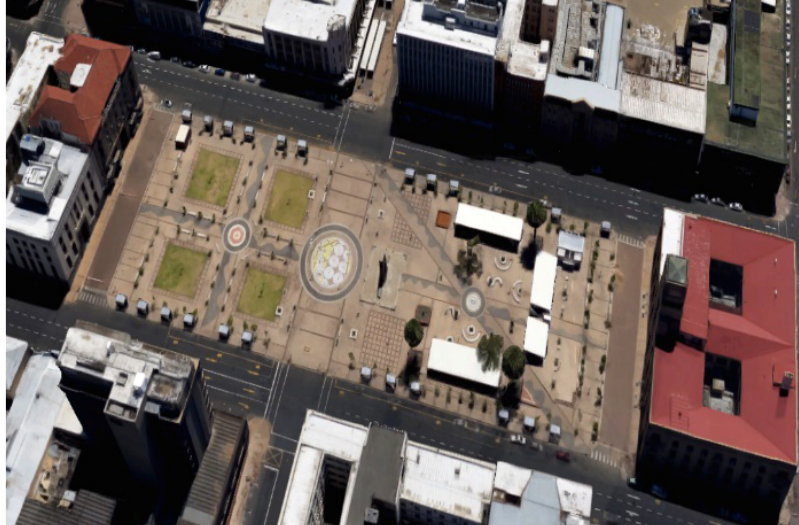
Figure 2. Contemporary Hoffman Square in Bloemfontein. Source: Google